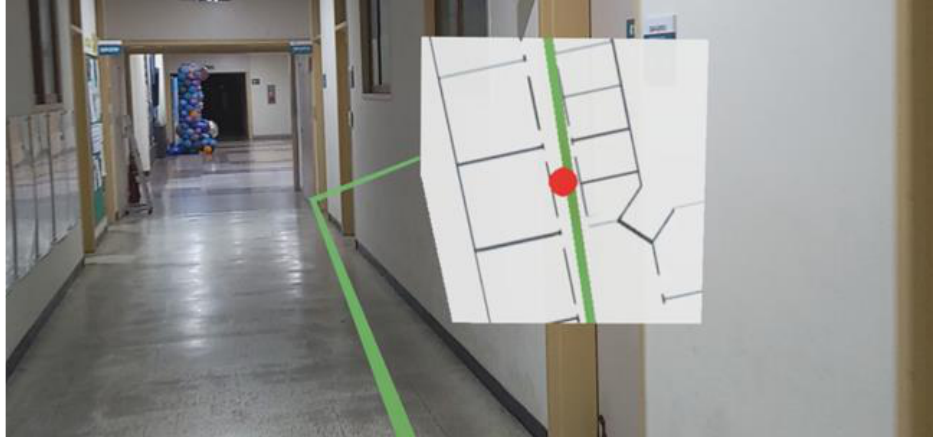
Figure 10. Visualisation of the pathfinding process after the user selects the destination point with Microsoft HoloLens2.